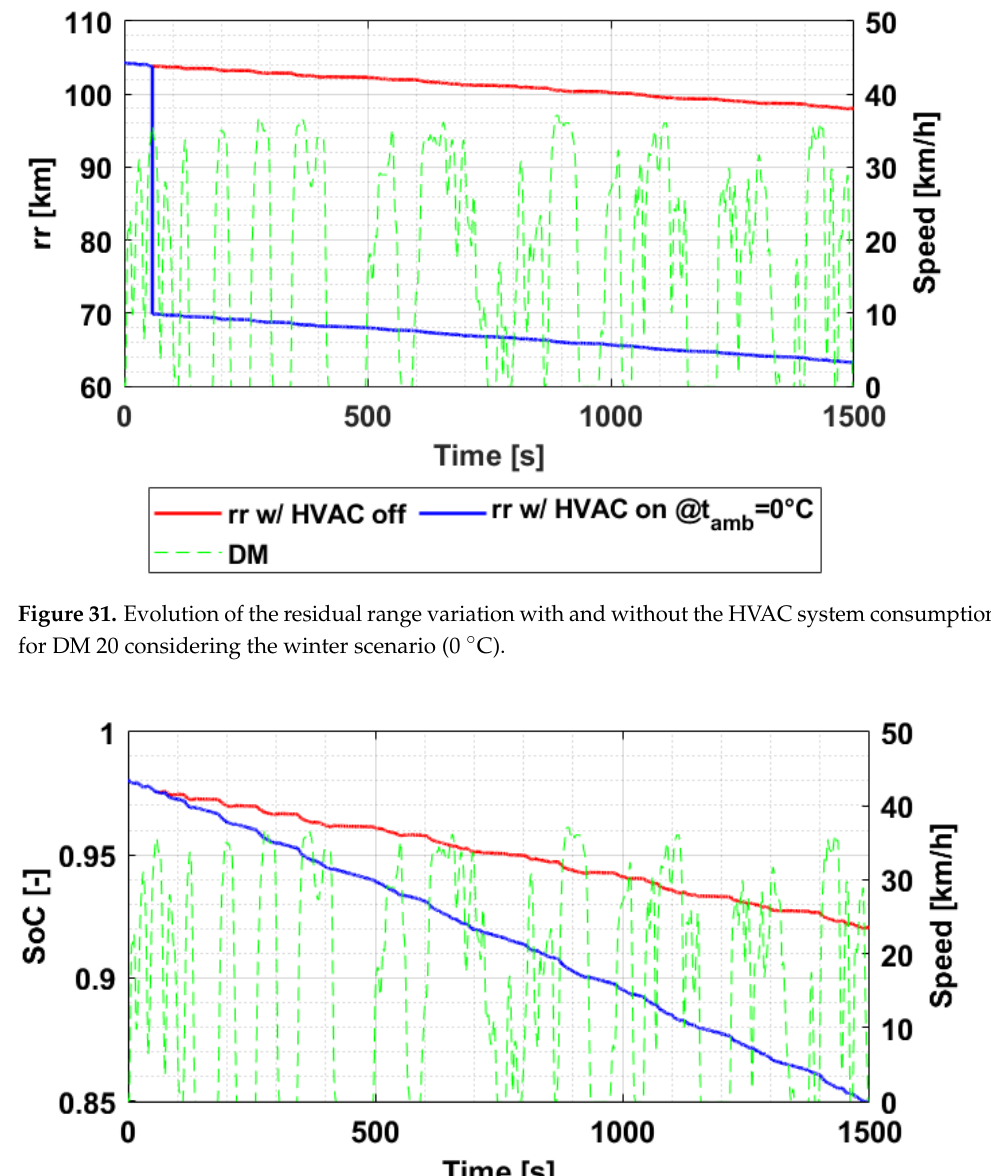
Figure 32. Evolution of the battery SoC variation with and without the HVAC system consumption for DM 20 considering the summer scenario (35 °C).